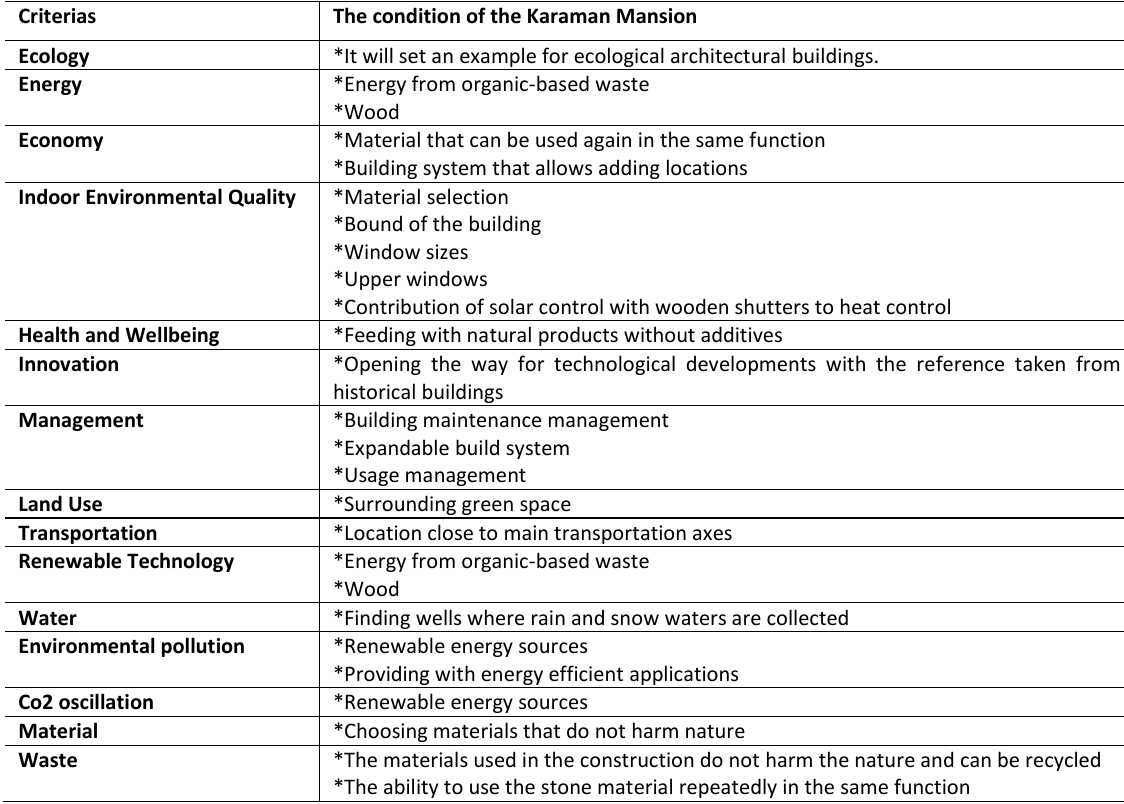
Table 1 Karaman Mansion Ecology Criteria